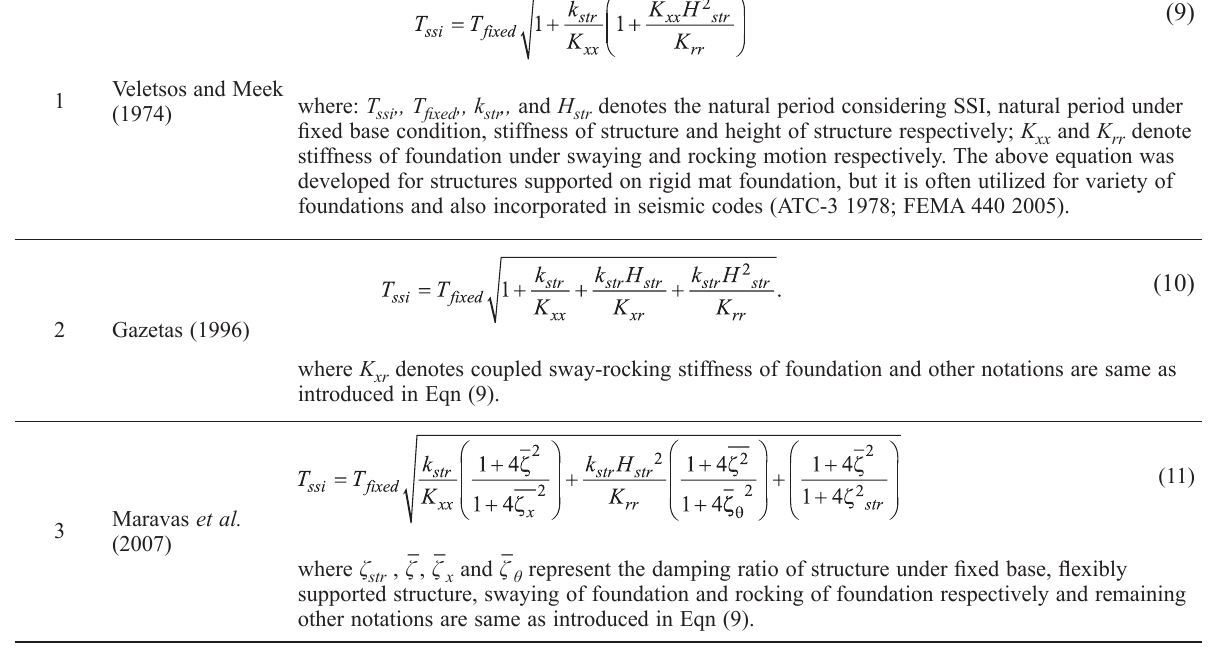
Table 5. Classical expressions for calculating natural time period of structure incorporating SSI (Rovithis et al. 2009) Relation proposed Sl. No.